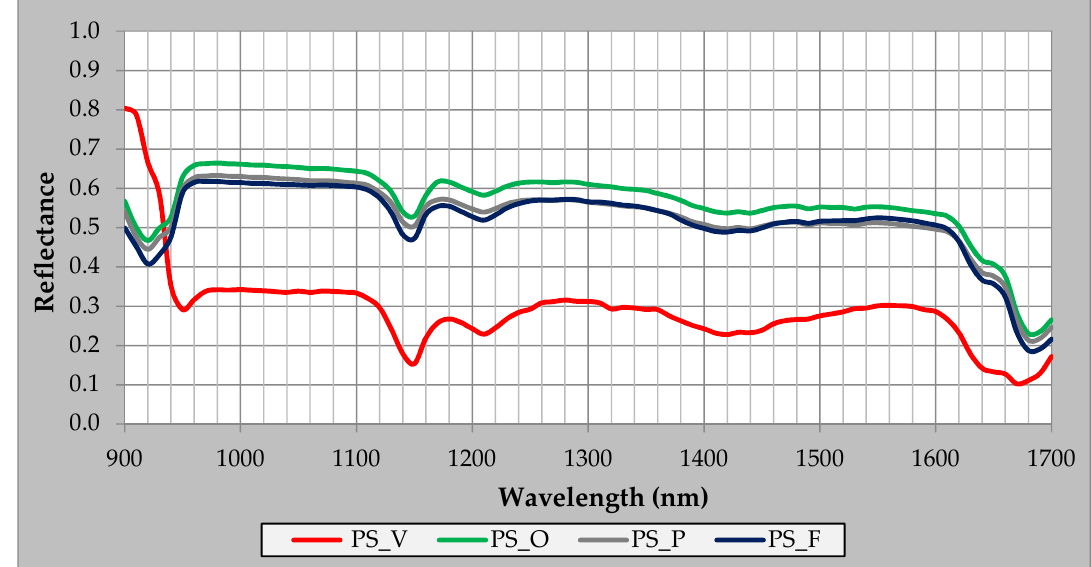
Figure 3. Spectral signatures of PS samples in the NIR region detected with the linear spectrometer.